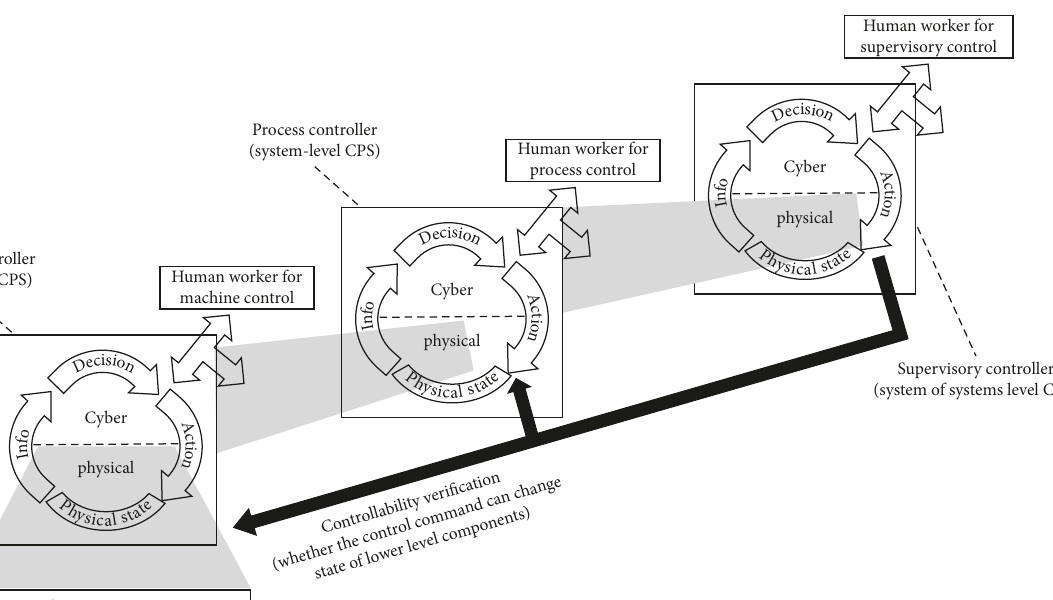
Figure 2: CPPS conceptual model.